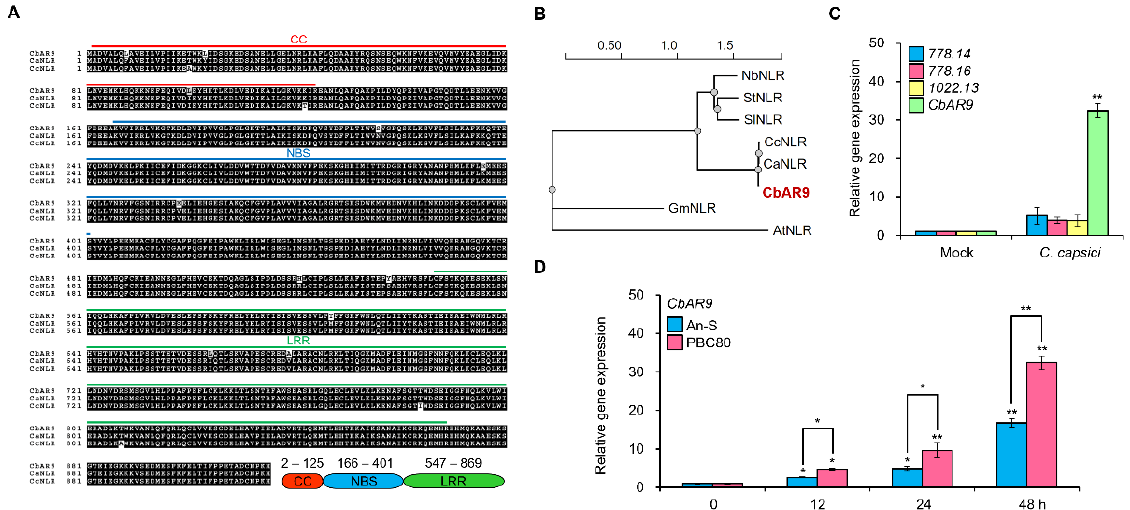
Figure 2. CbAR9 encodes a highly conserved NLR protein, and its expression is induced by Colletotrichum capsici infection. ( A ) Multiple protein sequence alignment between CbAR9 and two homologous NLR proteins from Capsicum annuum (XP_016566298) and Capsicum chinense (PHU21239). Red, CC domain; blue, NBS domain; green, LRR domain. ( B ) Phylogenetic analysis of CbAR9. A neighbor-joining tree was constructed with NGPhylogeny software using the full-length protein sequence of CbAR9, CaNLR (XP_016566298), CcNLR (PHU21239), NbNLR (QER78241), SlNLR (XP_010319428), StNLR (XP_015161267), GmNLR (XP_006601748), and AtNLR (NP_001332515). The scale bar represents the proportion of site changes along each branch. ( C ) Relative transcription levels of CB.CBv1.2.scaffold778.14/778.16/1022.13 and CbAR9 in PBC80 after C. capsici inoculation for 48 h, as determined by RT-qPCR. Actin served as internal reference. Data are shown as means ± SD. Asterisks indicate statistically significant differences from controls (** p < 0.01). ( D ) Relative CbAR9 transcript levels in An-S and PBC80 after C. capsici infection for the indicated times, as determined by RT-qPCR. Actin served as the internal reference. Data are shown as means ± SDs. Asterisks indicate statistically significant differences from controls (* p < 0.05 and ** p < 0.01). The experiments were repeated at least three times, with similar results.